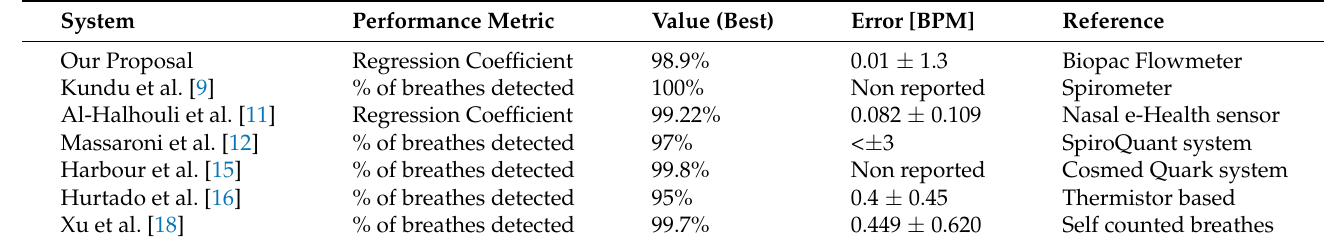
Table 6. State-of-the-Art performance comparison of breathing rate